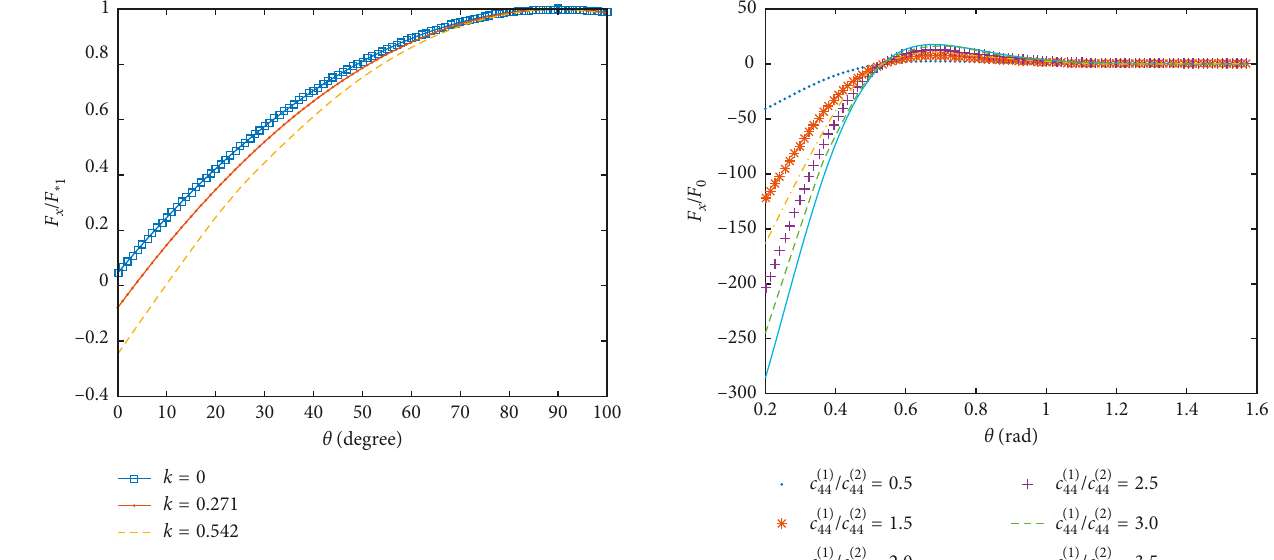
z along the x -axis versus